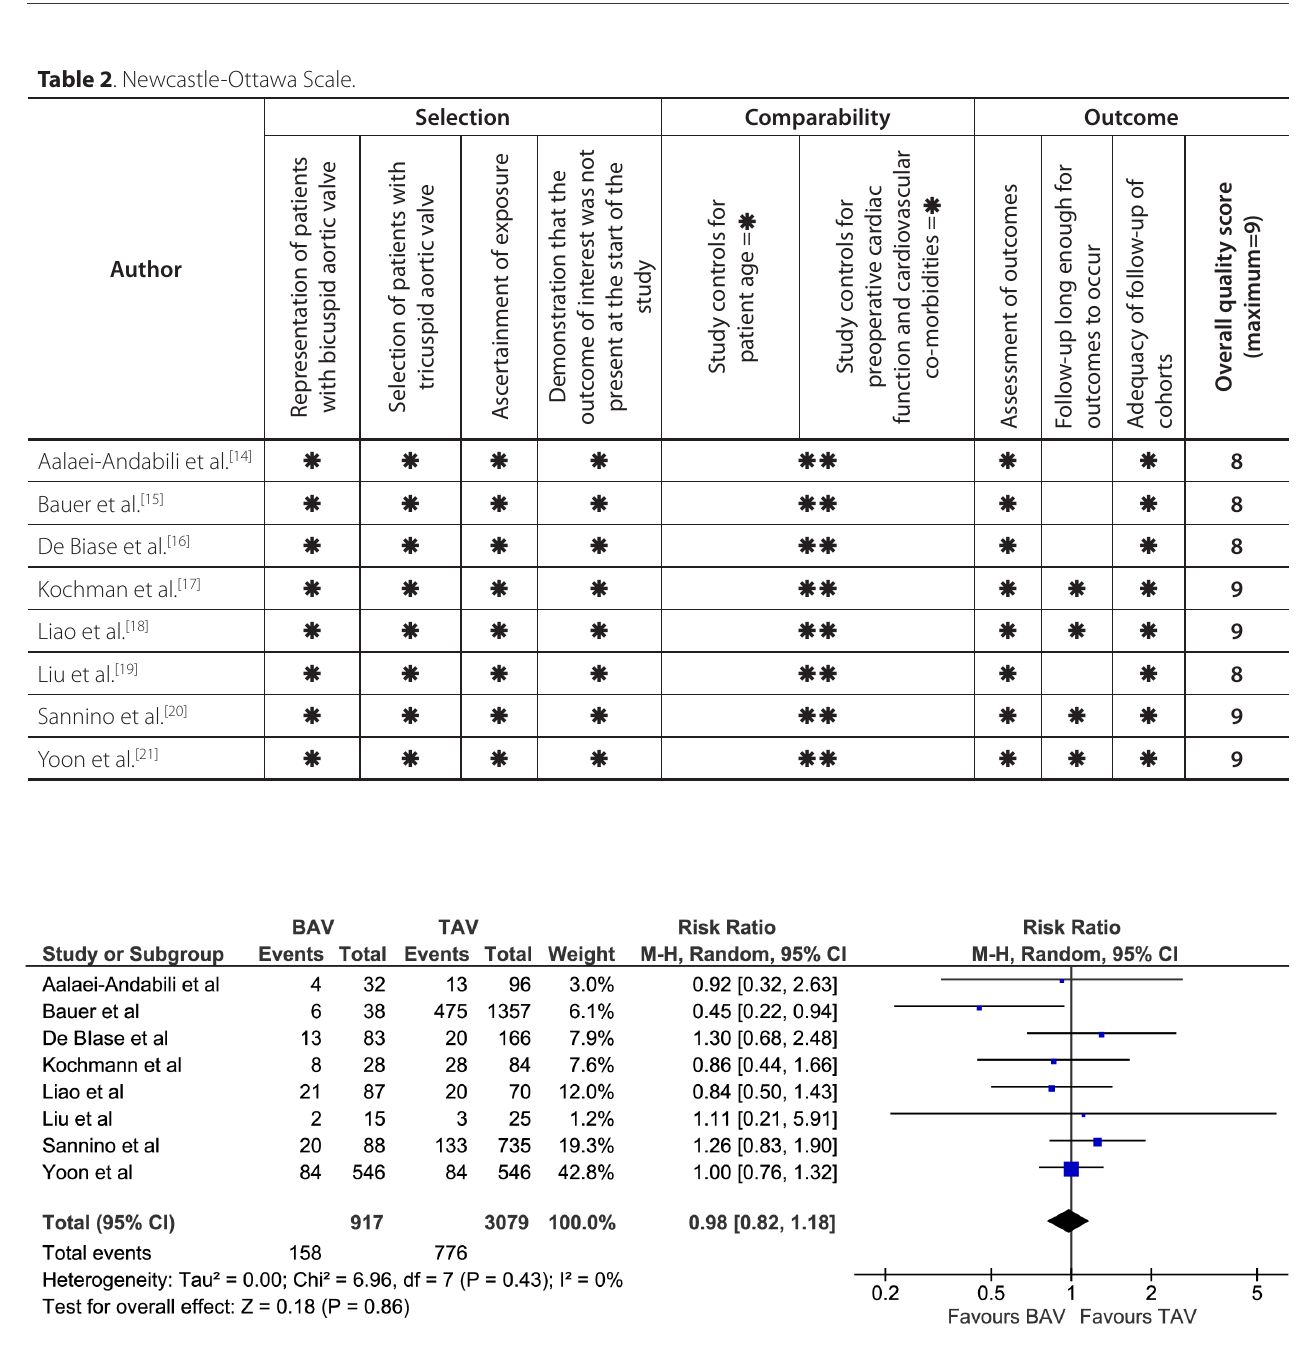
cumulative Z curve of the study data crossed the futility boundary and/or the trial sequential monitoring boundary, indicating that the meta-analysis of these variables was conclusive. However, the cumulative Z curves for postoperative stroke (Figure 10) did not cross any of the boundaries, indicating that meta-analyses of these variables were inconclusive, and further studies were required. TSA